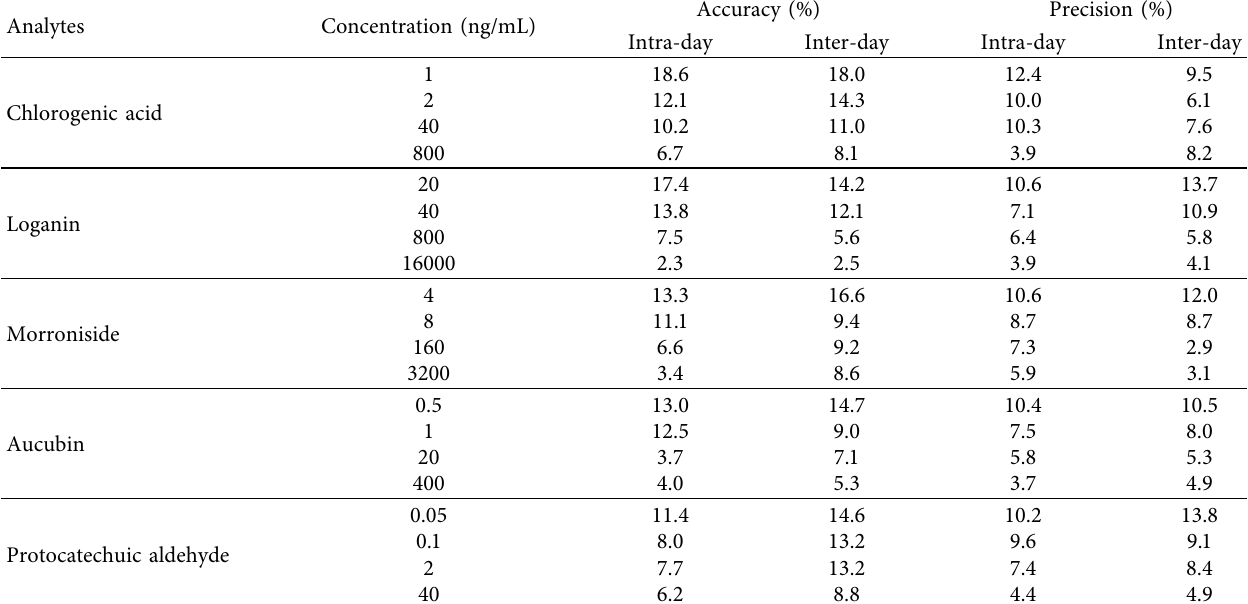
Table 4: Accuracy and precision of 5 analytes in rat plasma ( n �